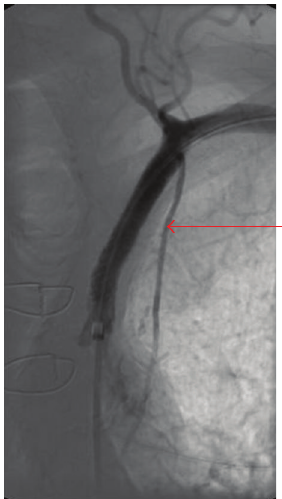
Figure 5: The left subclavian artery with implanted stents. Renewal of anterograde blood flow in the left mammary artery